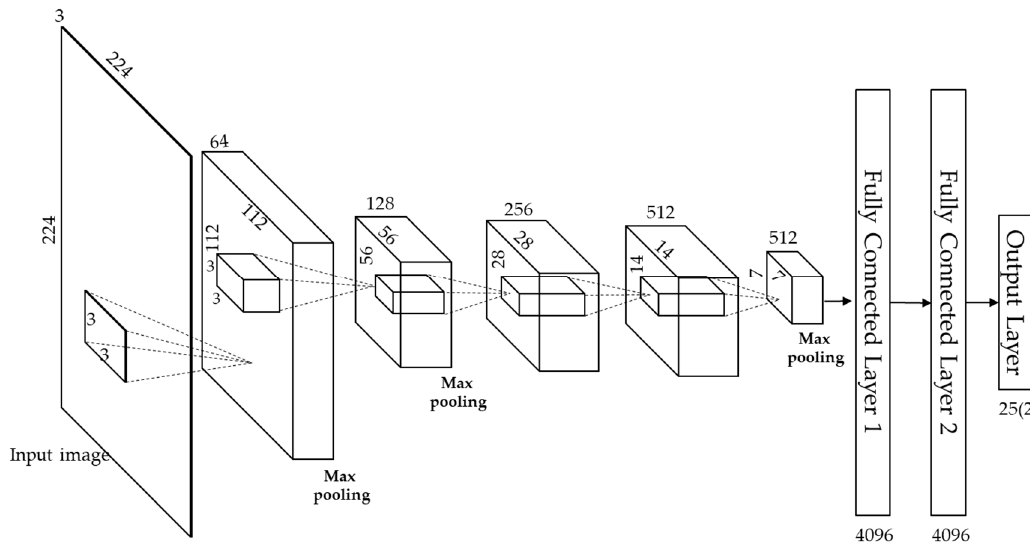
Figure 9. CNN Architectures used for classifying driving behavior.